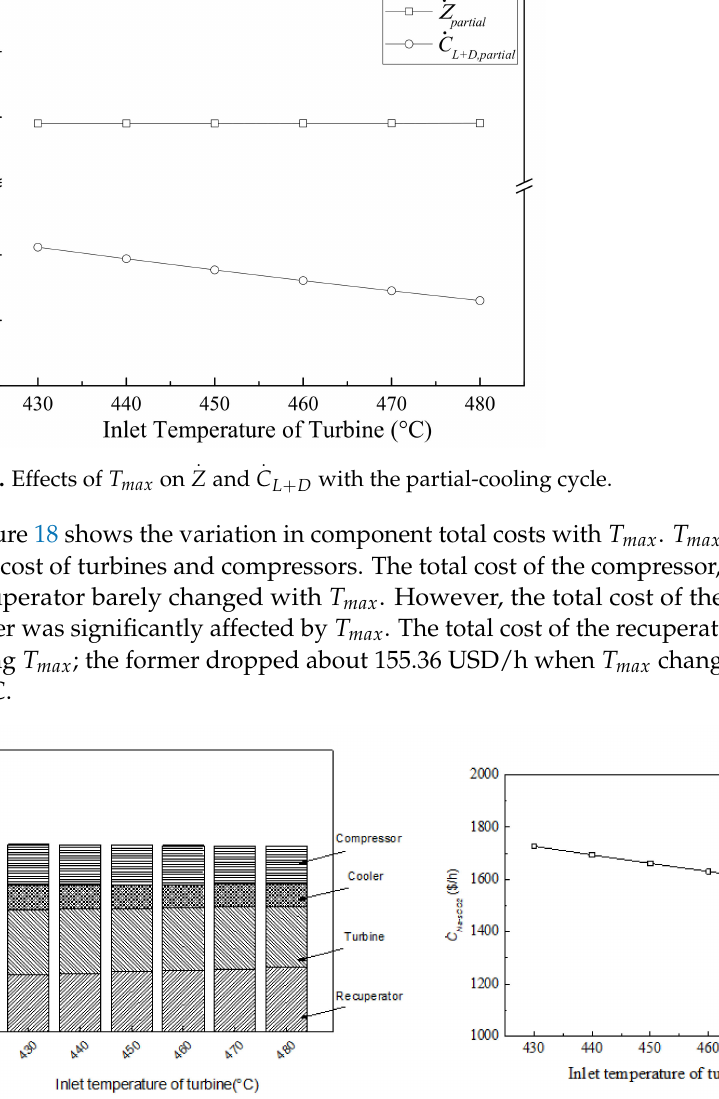
. C component with the partial-cooling cycle. ( a ) Multiple components, Figure 18. Effects of T max on ( b ) Na-sCO 2 heat